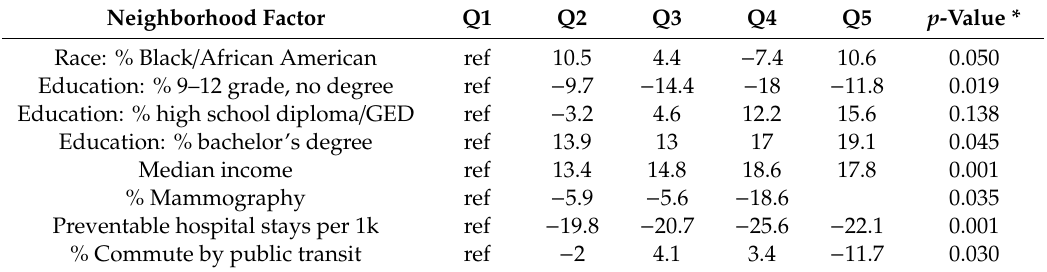
Table 4. Coe ffi cient estimates by quantile group: Neighborhood-level factors and overall well-being. Neighborhood Factor Q1 Q2 Q3 Q4 Q5 p -Value * Race: % Black / African American